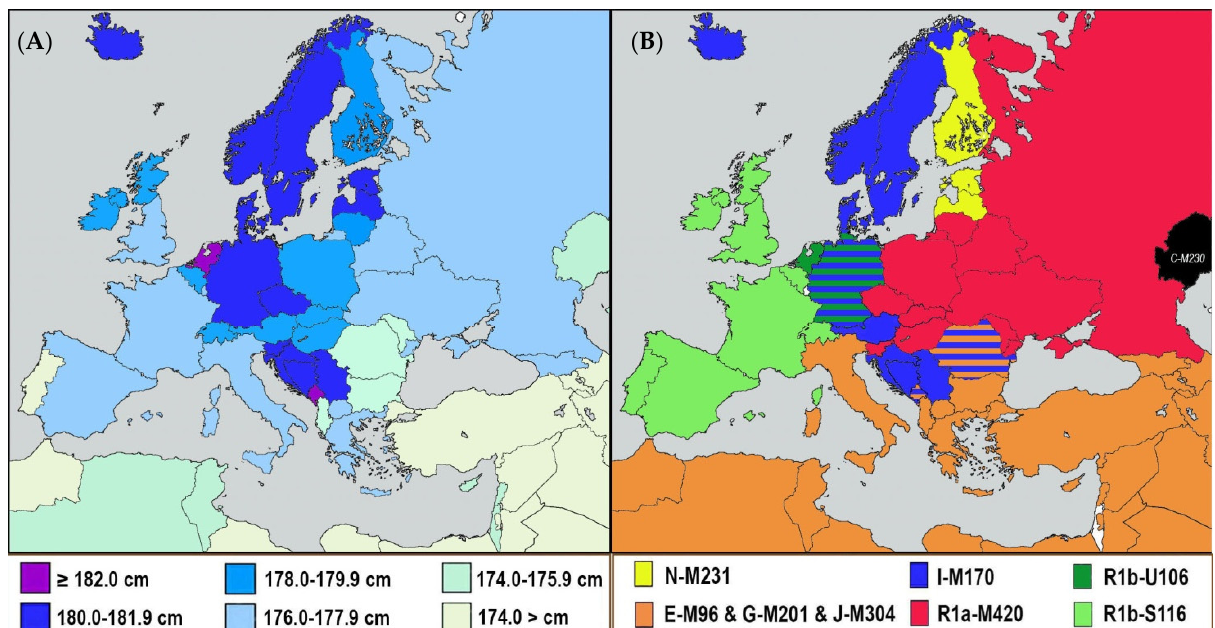
Figure 5. ( A ) The actual distribution of male height in Europe. ( B ) The most frequent Y haplogroups (or their combination) in European nations. The frequencies of Y haplogroups that do not differ by more than 1% are indicated by hatching.